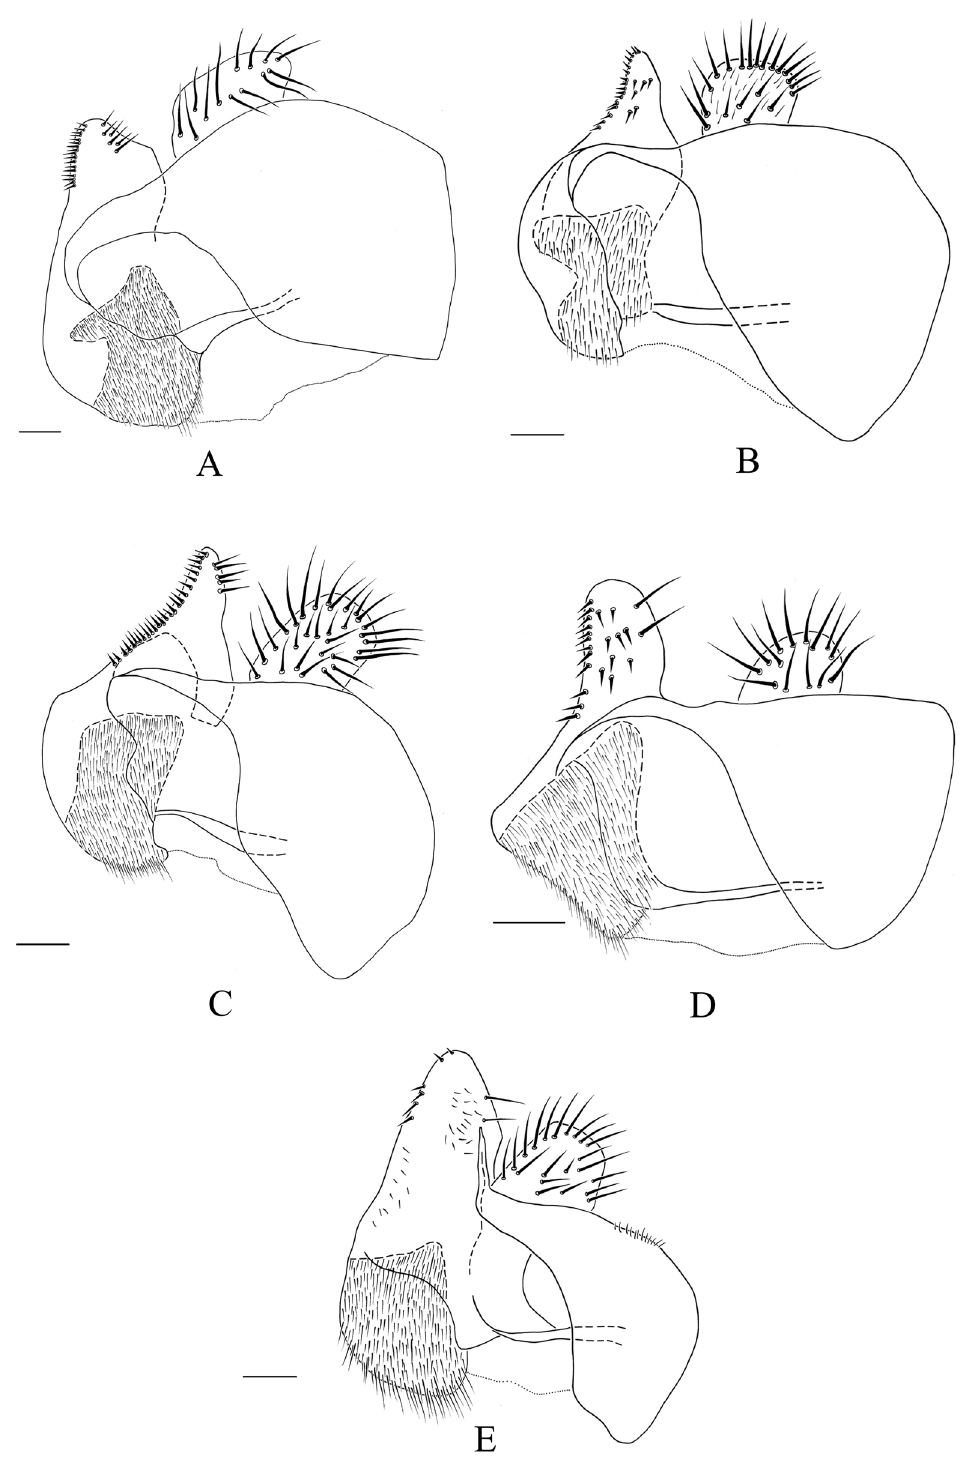
Fig. 19. Epandrium, cercus and surstylus, lateral view. A . Eumerus hissaricus Stackelberg, 1949, Ghoochan, Iran (HMIM). B . E. kazanovzkyae Paramonov, 1927, Paveh, Iran (HMIM). C . E. pilosipedes Gilasian & van Steenis sp. nov., holotype (HMIM). D . E. vallicolus Gilasian & van Steenis sp. nov., holotype (HMIM). E . Eumerus sp., Khash, Iran (HMIM). Scale bars = 0.1